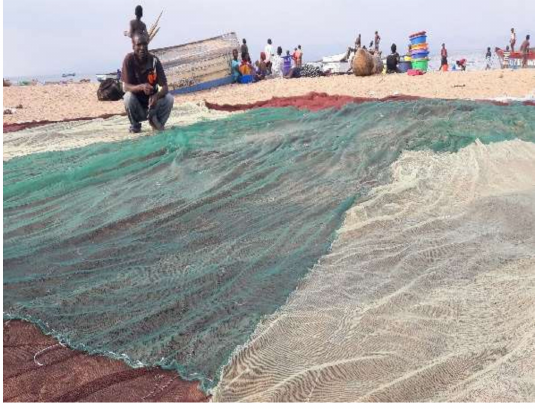
Figure 2. Mosquito nets attached to fishing nets.